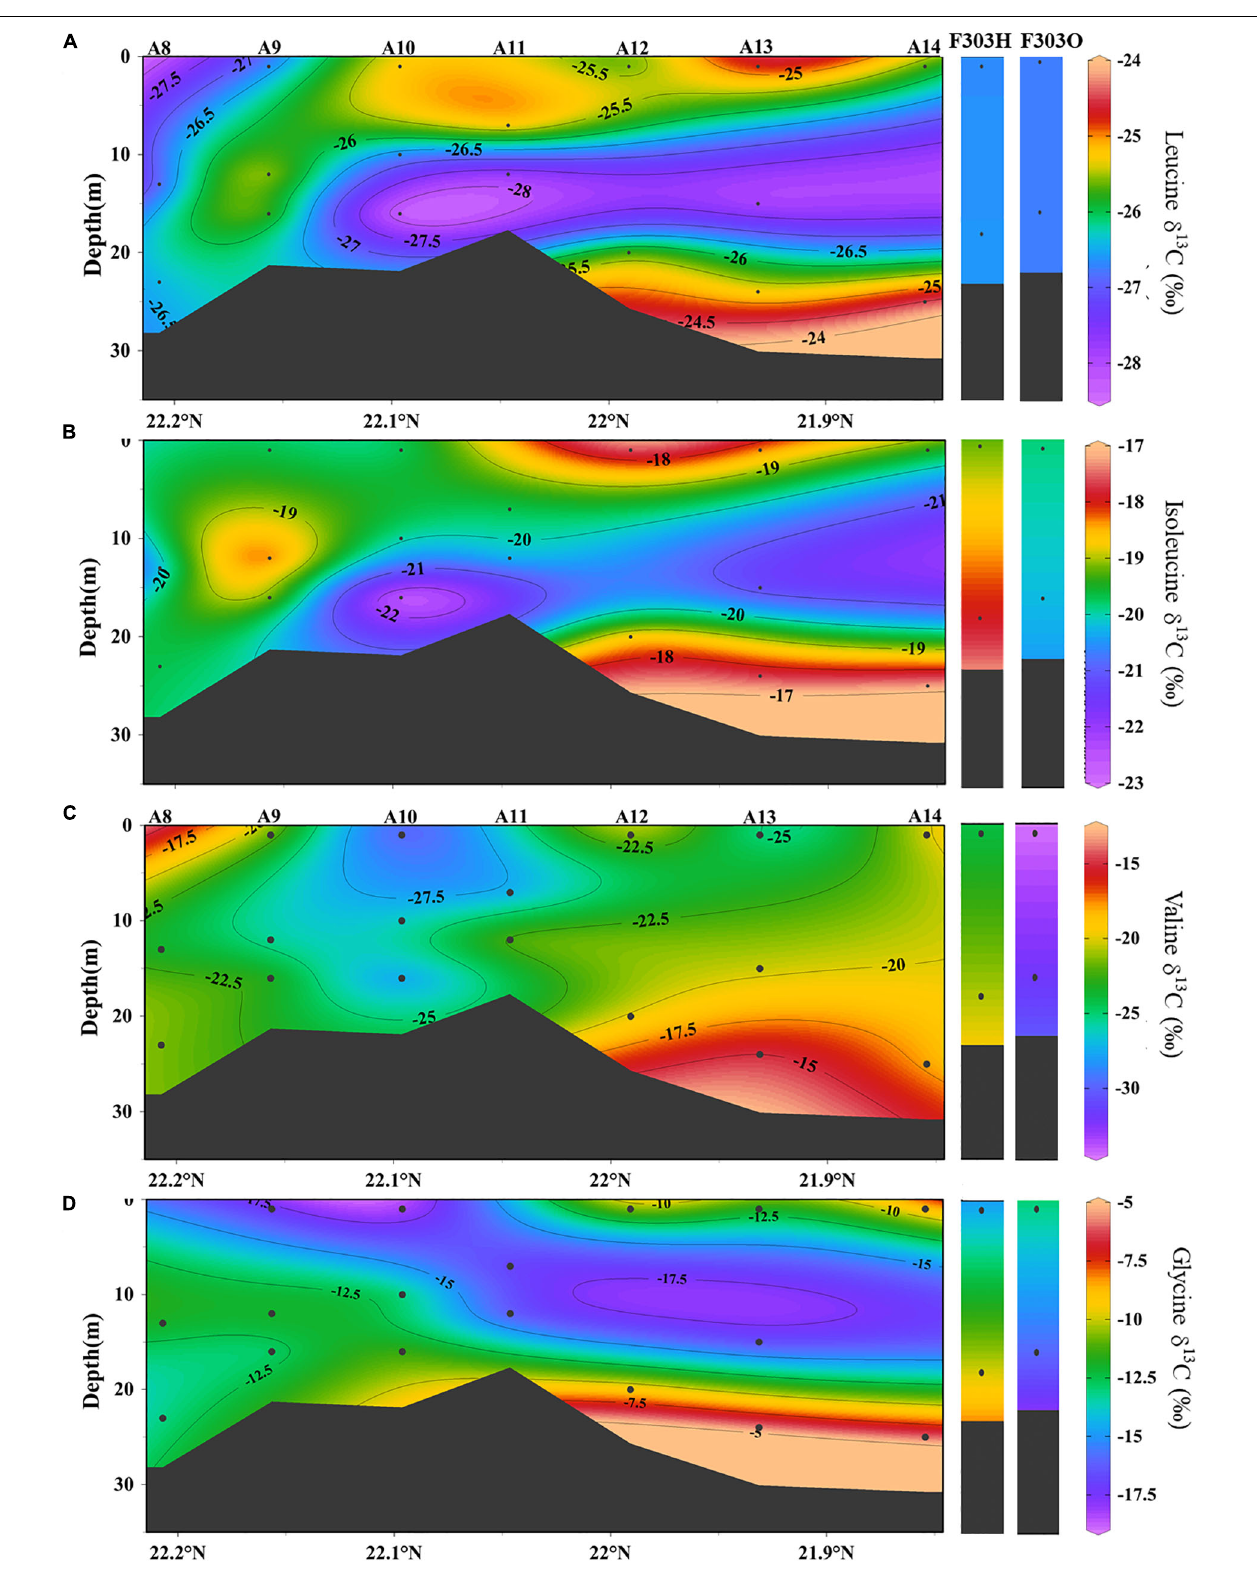
FIGURE 5 | The distribution of δ 13 C values in particles from transect A and station F303 on the NSCS shelf: (A) leucine δ 13 C, (B) isoleucine δ 13 C, (C) valine δ 13 C, and (D) glycine δ 13 C. Station F303H and F303O are the two visits to station F303 before and after the Typhon Son-Tinh, respectively.